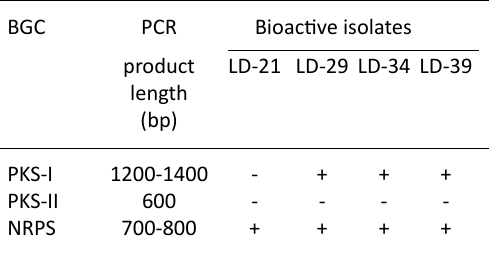
Table 2. Detection of biosynthetic gene clusters (BGCs) in bioactive isolates by PCR